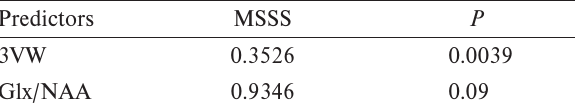
Table 3. Identification of the most relevant predictors via regression